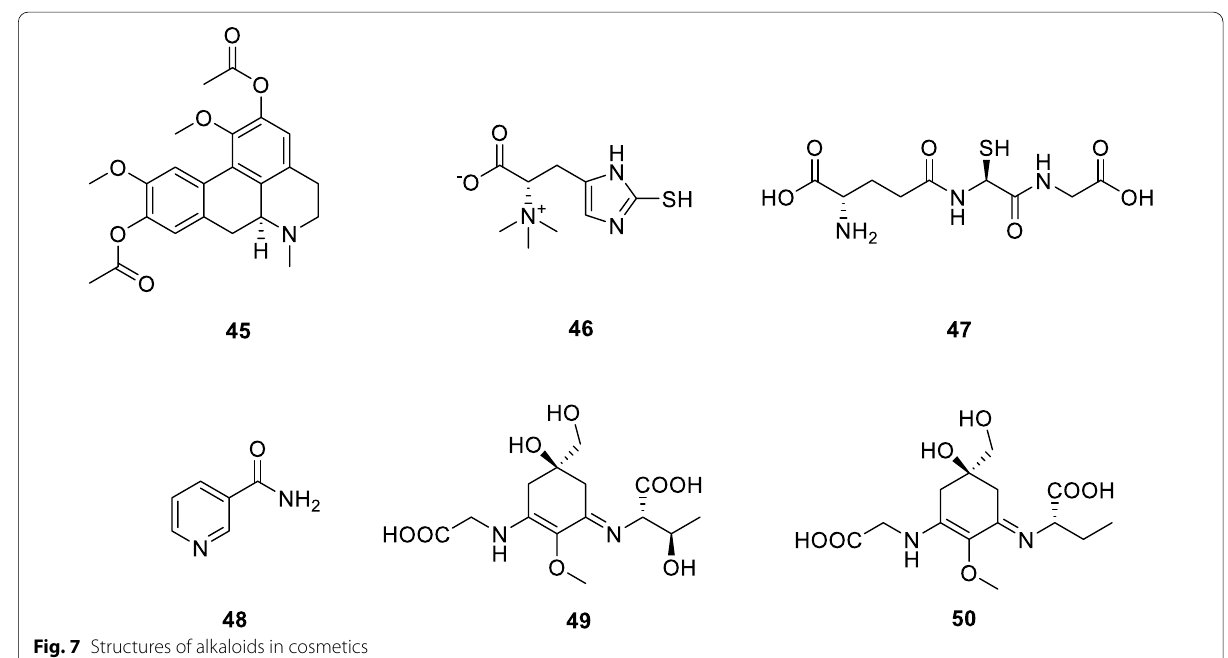
Fig. 7 Structures of alkaloids in